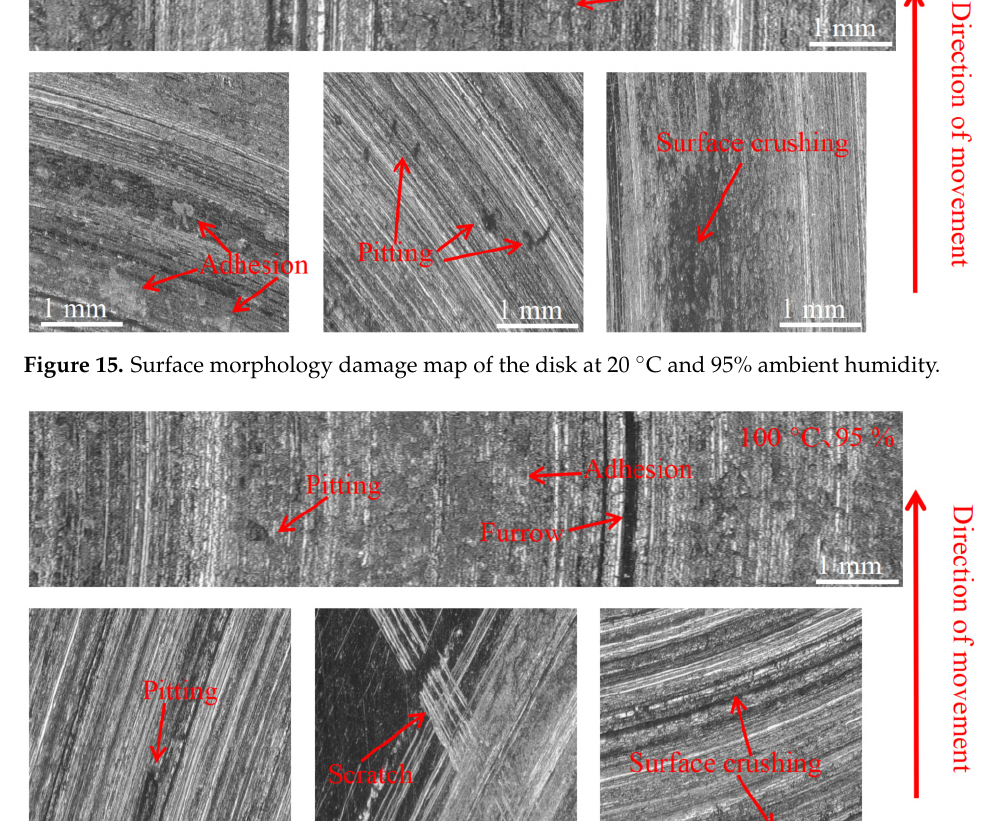
Figure 16. Surface morphology damage map of the disk at 100 °C and 95% ambient humidity.